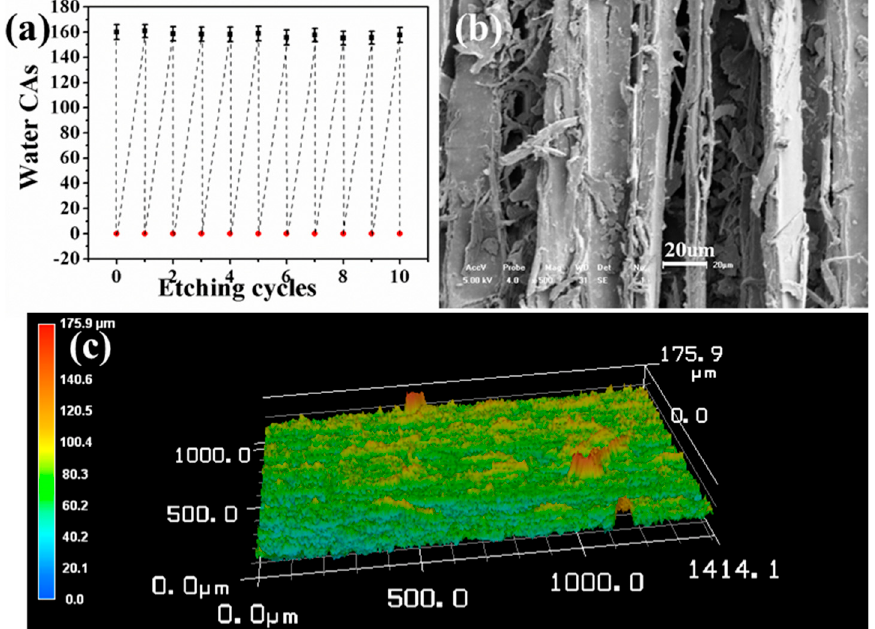
Figure 6. ( a ) Water CAs of the surface after repeated alkaline etching and self-healing at room temperature. ( b )SEMand( c temperature. ( b ) SEM and ( c ) 3D OPM images of the surface of coated sanded wood after alkaline etching.